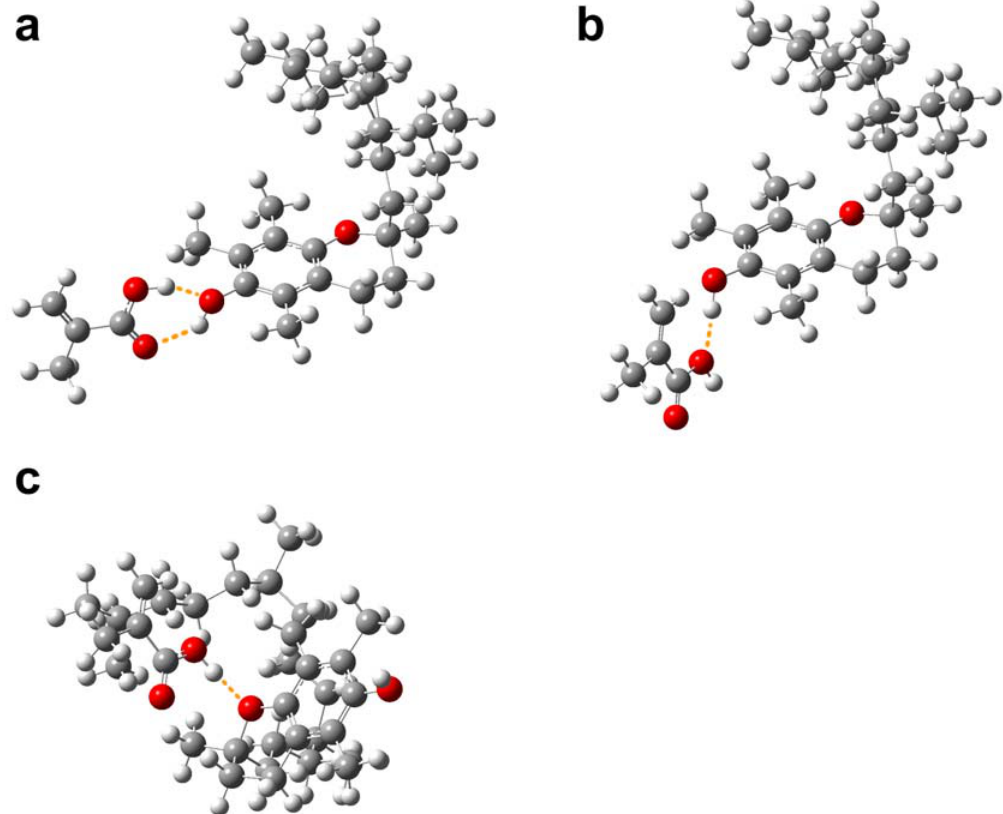
Figure 8. Possible modes of interaction of TP with